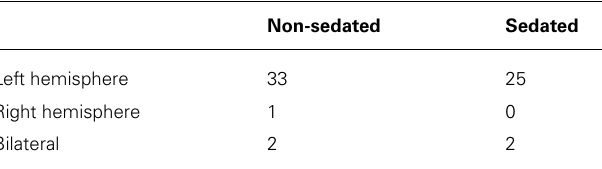
Table 3 | Judgments on hemispheric dominance for receptive language in non-sedated and sedated